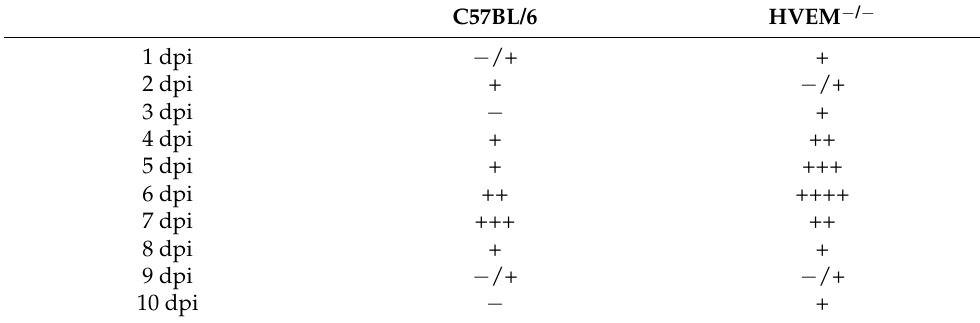
Table 1. Pathological analysis of C57BL/6 mice and HVEM − / − mice infected with McKrae ( n = 3 per time point in each